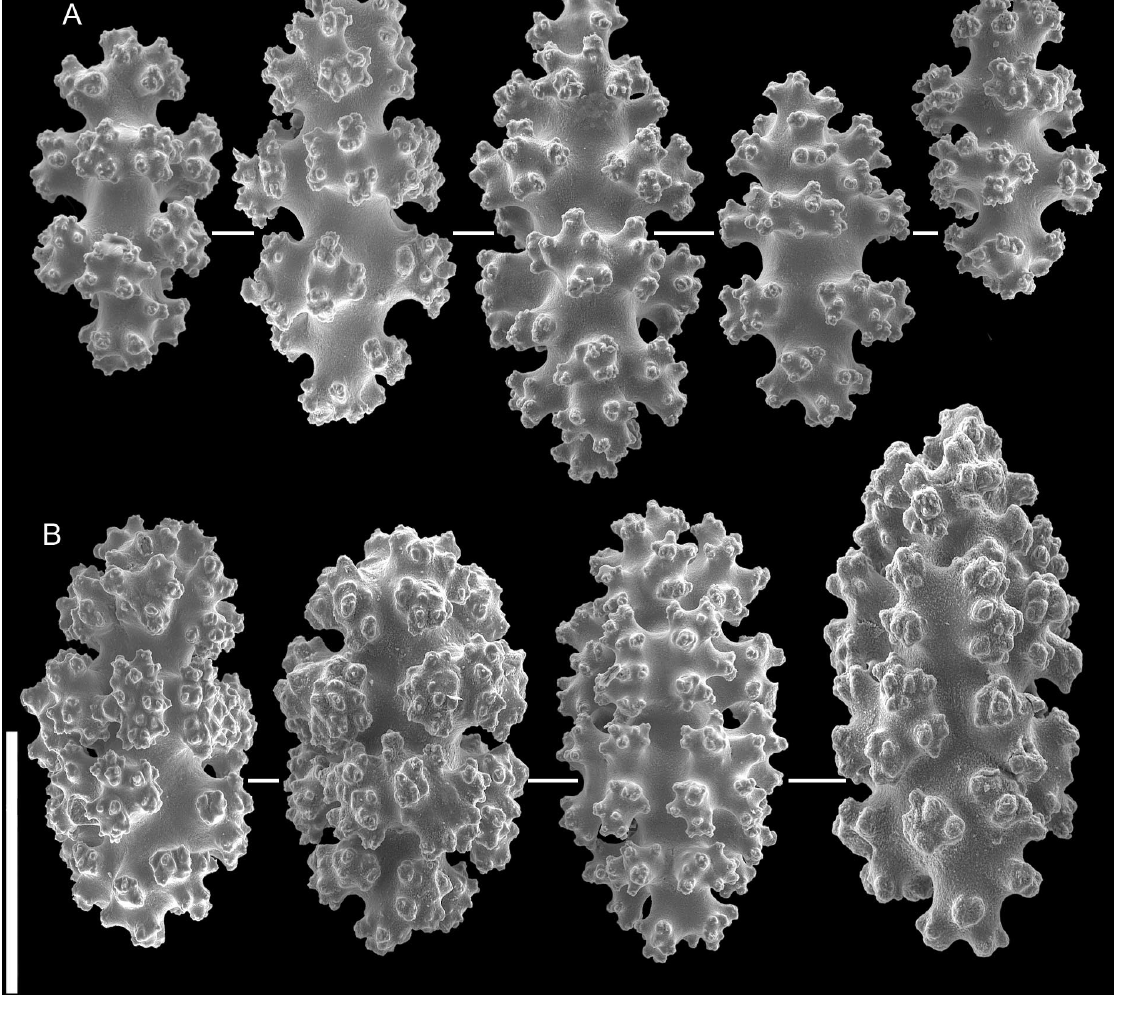
Fig. 7. Calcigorgia herba sp. nov., paratype MIMB 20745, sclerites from the coenenchyme. A . Well calcified capstans (8-radiate). B . Ovals. Scale bar = 0.1